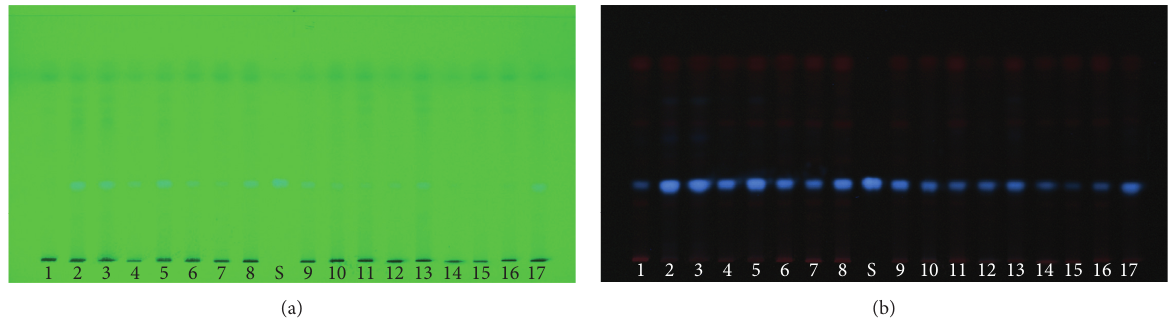
Figure 3: Cassiarin A standard (S) and C. siamea leaf ethyl acetate fraction (numbering as in Table 3) from 17 regions in Indonesia. (a) TLC plate under UV 254nm. (b) TLC plate under UV 366nm.